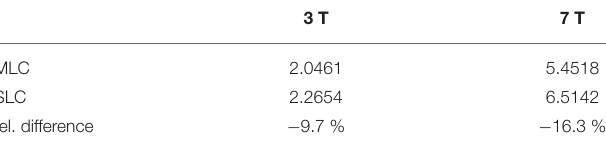
TABLE 3 | Maximum 10 g-averaged SAR